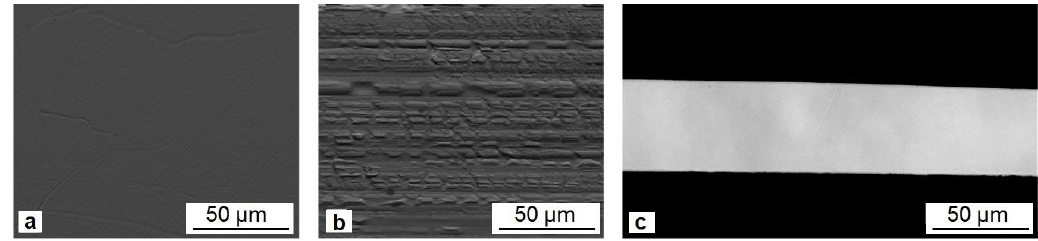
Figure 2. Typical images of non-contact ( a ) and contact ( b ) surfaces and cross section ( c ) of rapidly quenched TiNiCu ribbons (for the alloy with 34 at.% Cu).